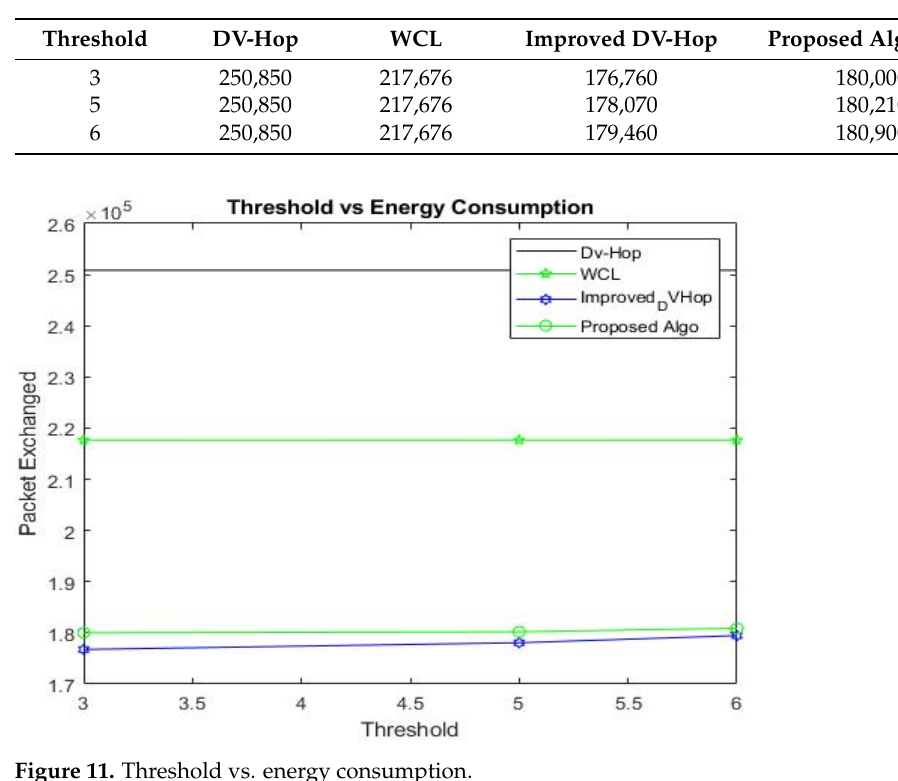
Table 12. Comparison of the proposed algorithm, in terms of energy consumption, using various threshold values (anchor nodes = 150).